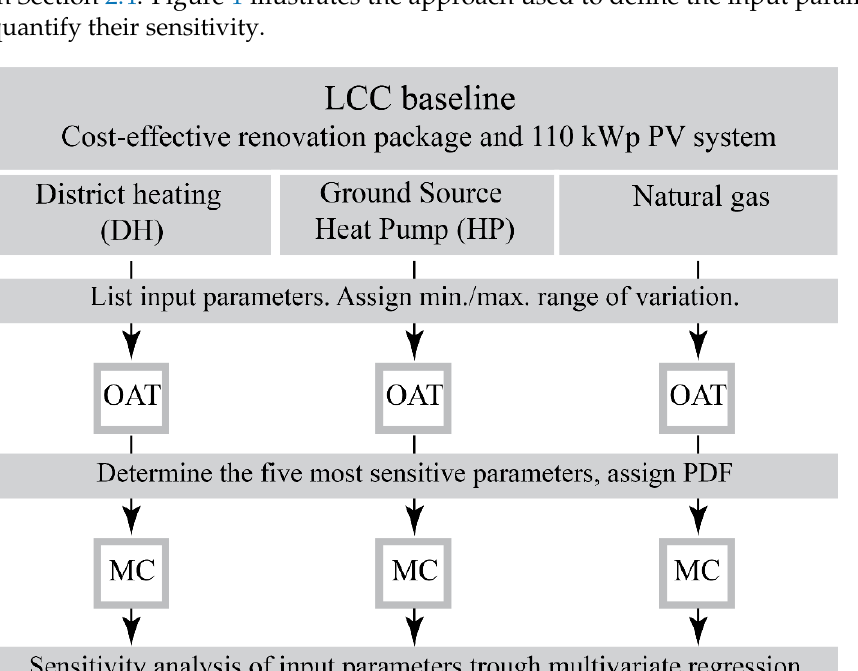
Figure 1. Diagram of sensitivity study applied in this paper.